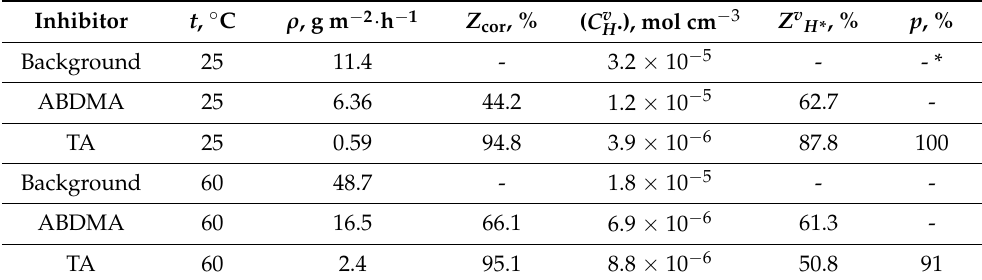
Table 2. Effect of 5 mmol of nitrogen-containing inhibitors on the corrosion, hydrogen absorption, and ductility of SS steel in 2 M HCl.